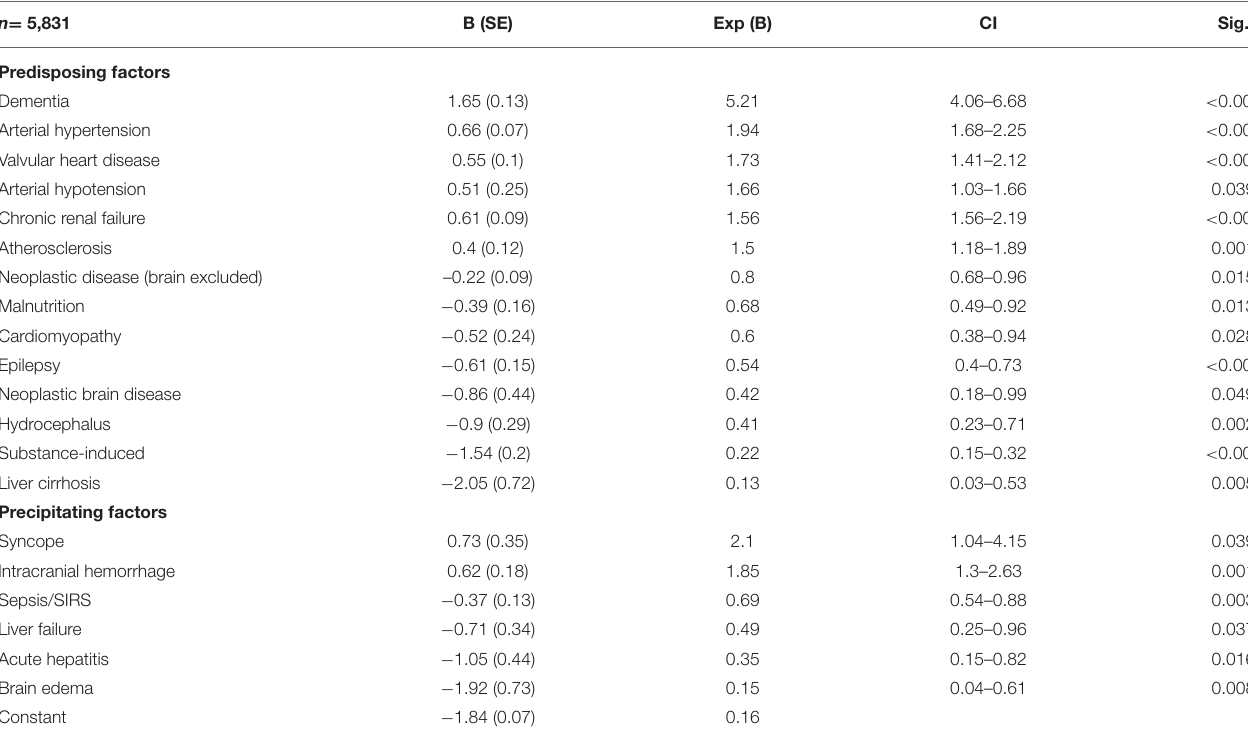
TABLE 3 | Predisposing and precipitating risk factors. n =